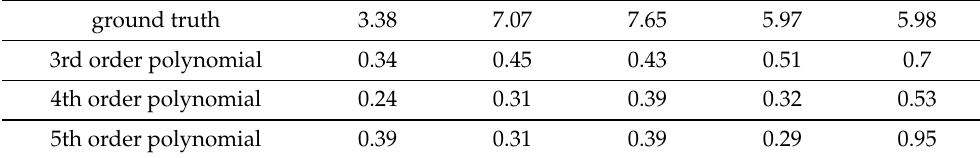
Table 2. Validation results on five calibration processes—reported in steps.